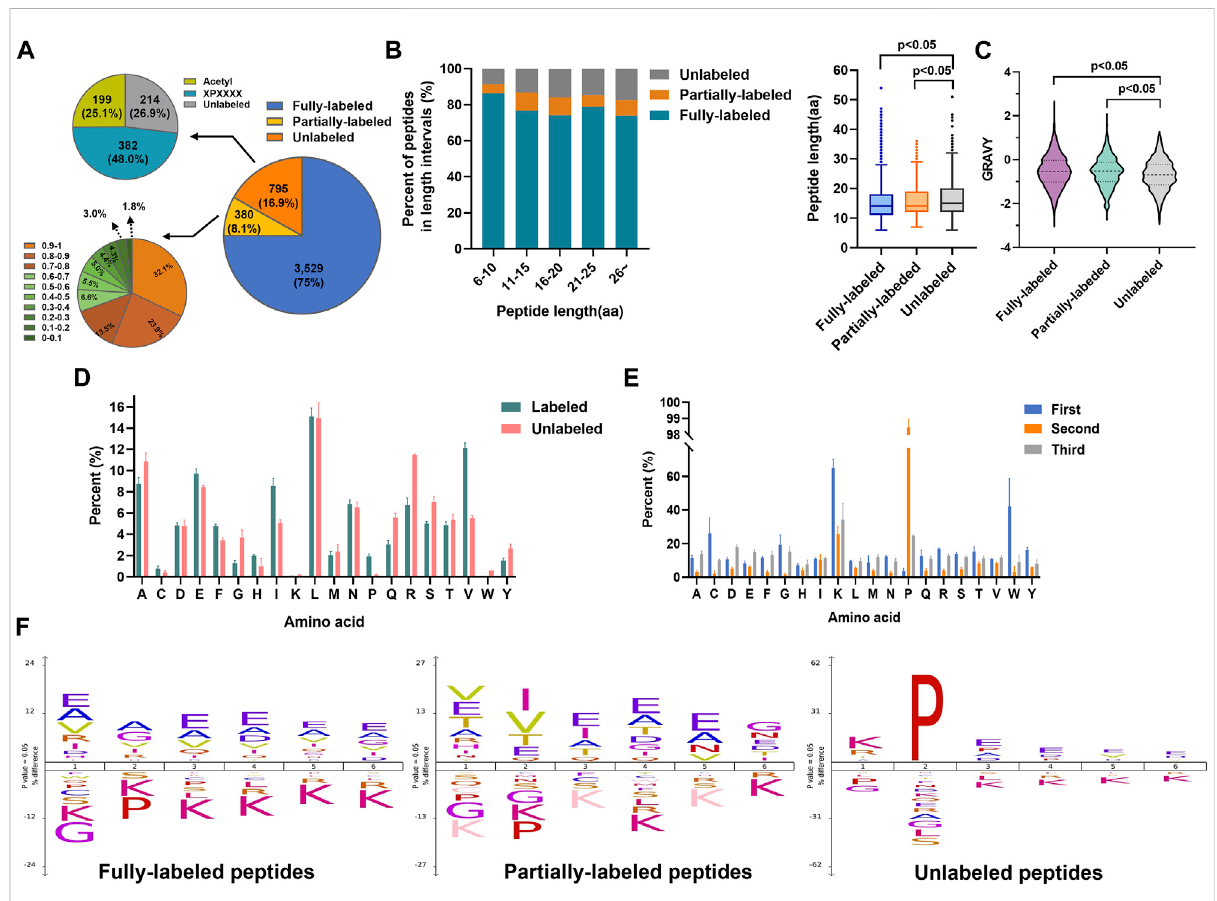
FIGURE 2 2-PCA displays ef fi ciently and high selectively labeling peptide N-terminal. (A) Pie chart of the 2-PCA labeling ef fi ciency distribution calculated by using the spectral counting-based quanti fi cation method. (B,C) 2-PCA labeling ef fi ciency of different length (B) and hydrophilic/hydrophobic value of peptide (C) . The GRAVY scores were calculated using the online tool (https://web.expasy.org/protparam/) (Kyte and Doolittle, 1982). The p -valuewascalculatedbypairedStudent t -test. (D,E) Fulllabeling (D) andun-labeling (E) peptidepercentondifferent fi rstthreeaminoacids. (F) IceLogo analysis representation of the fi rst six amino acids of full labeling, partial labeling, and un-labeling